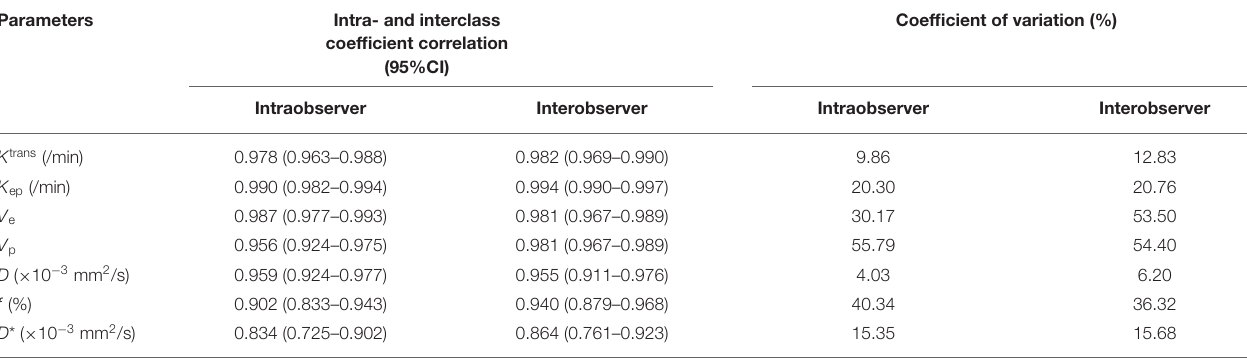
TABLE 3 | Intra- and interobserver reproducibility in the assessment of IVIM and DCE-MRI parameters in sacroiliitis with ankylosing spondylitis (AS).